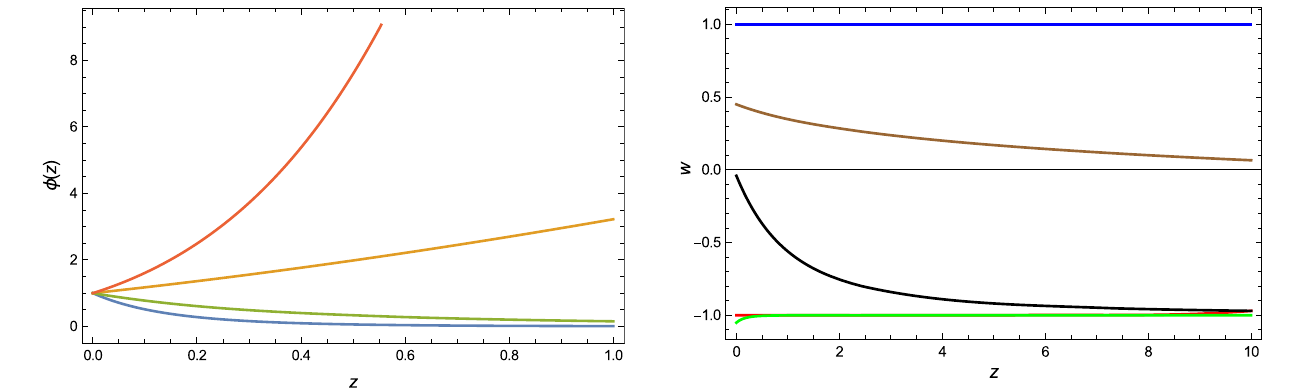
Fig. 4 Evolutionofequationofstatewithrespecttoredshiftforpower- law potential; for different range of redshift. The various colors take on the following values of the index n . Red: n = − 1 . 5, blue: n = − 0 . 7, brown: n = 0 . 09, black: n = 0 . 5, and green: n =